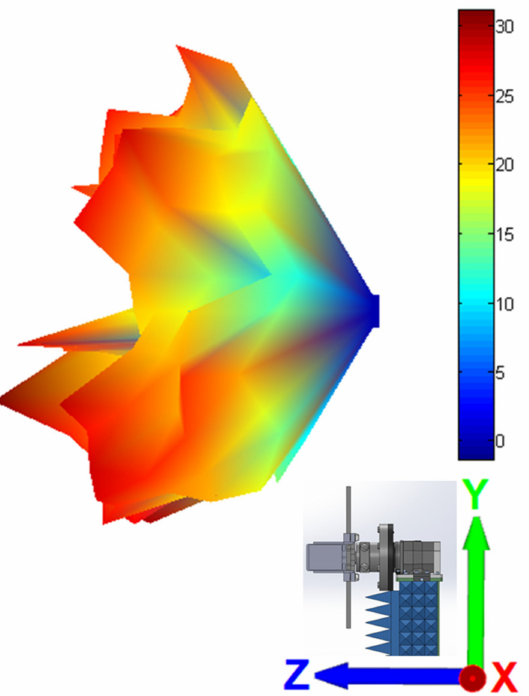
Figure 4. 5G beamforming capacity gain measured using an EMITE H300 anechoic